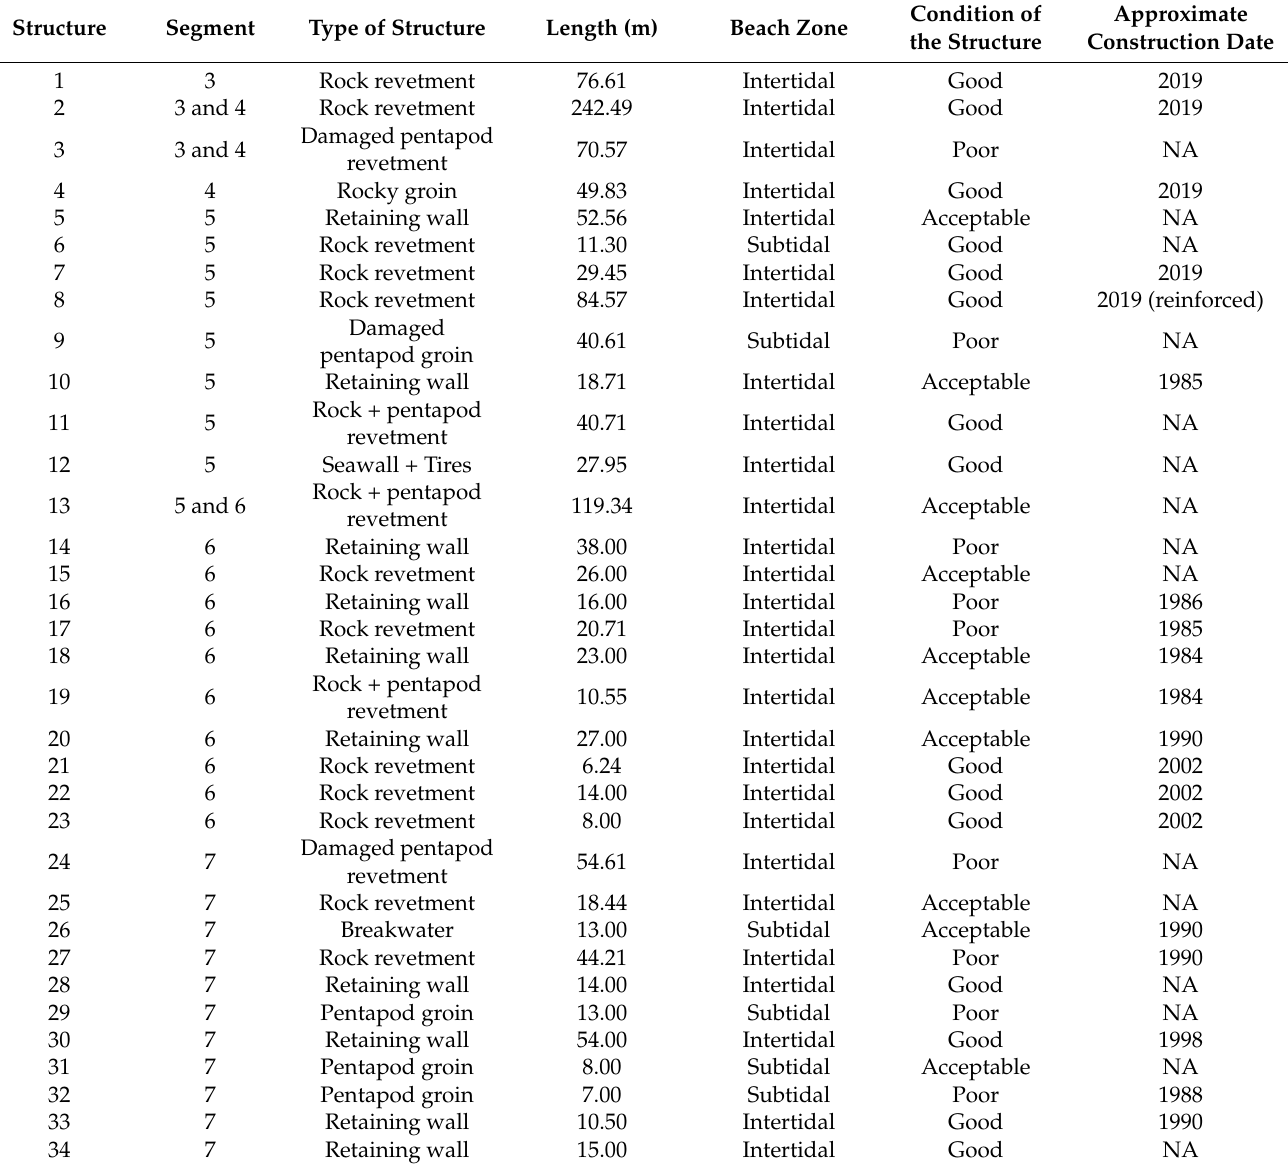
Table A1. Properties of coastal protection structures on the urban beaches of